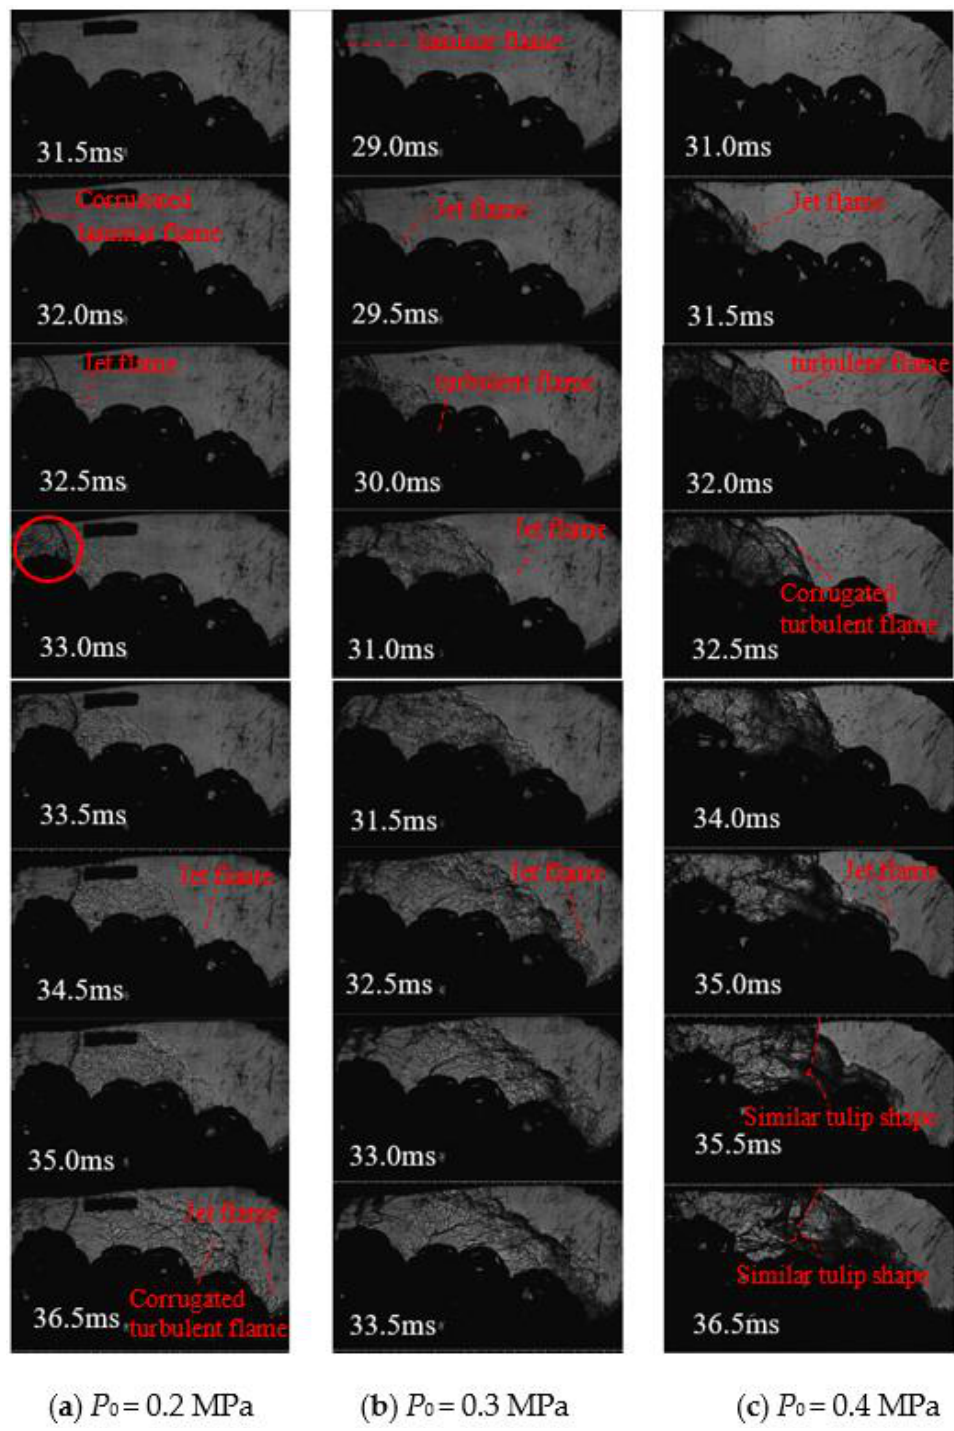
Figure 5. The process of flame propagation under three different initial pressures when the filling density is 21.9 kg/m 3 . density is 21.9 kg/m 3